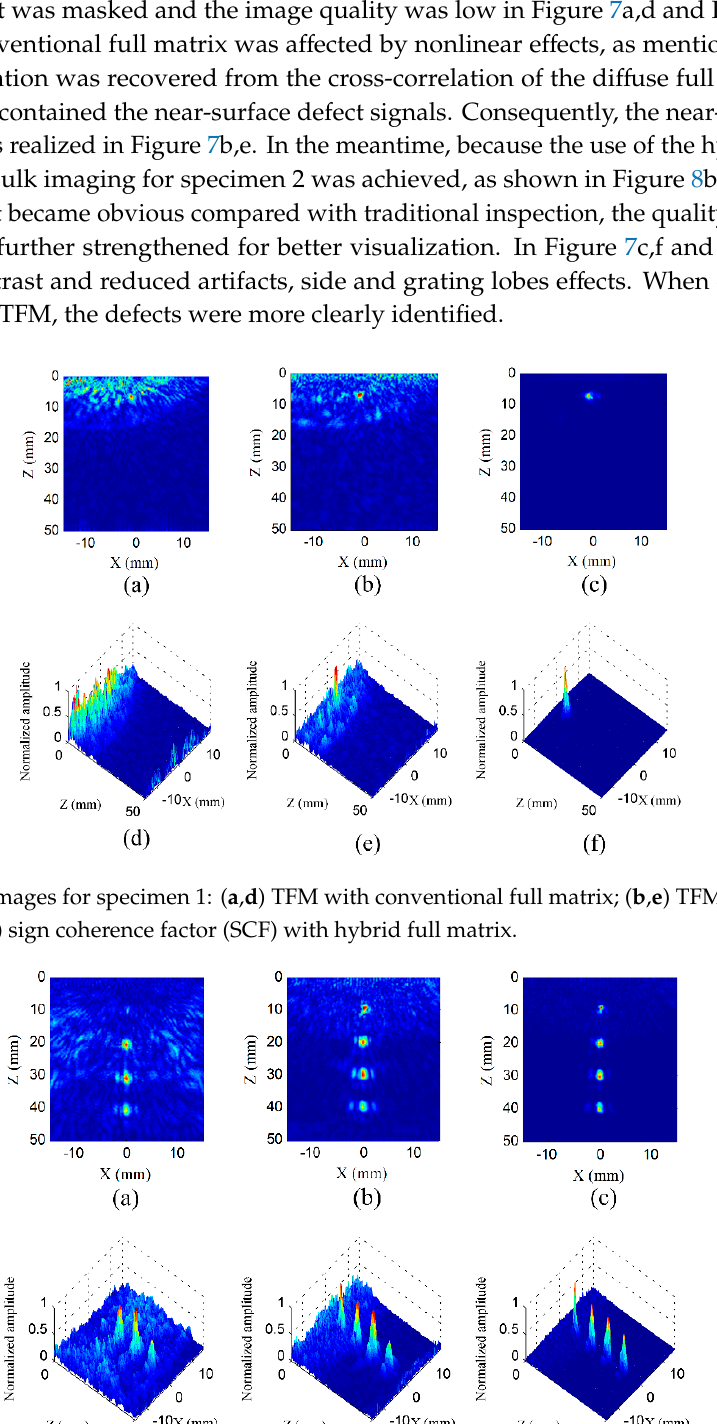
Figure 8. The images for specimen 2: ( a , d ) TFM with conventional full matrix; ( b , e ) TFM with hybrid full matrix; ( c , f ) SCF with hybrid full matrix.